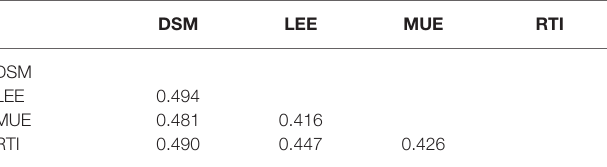
TABLE 6 | Discriminant